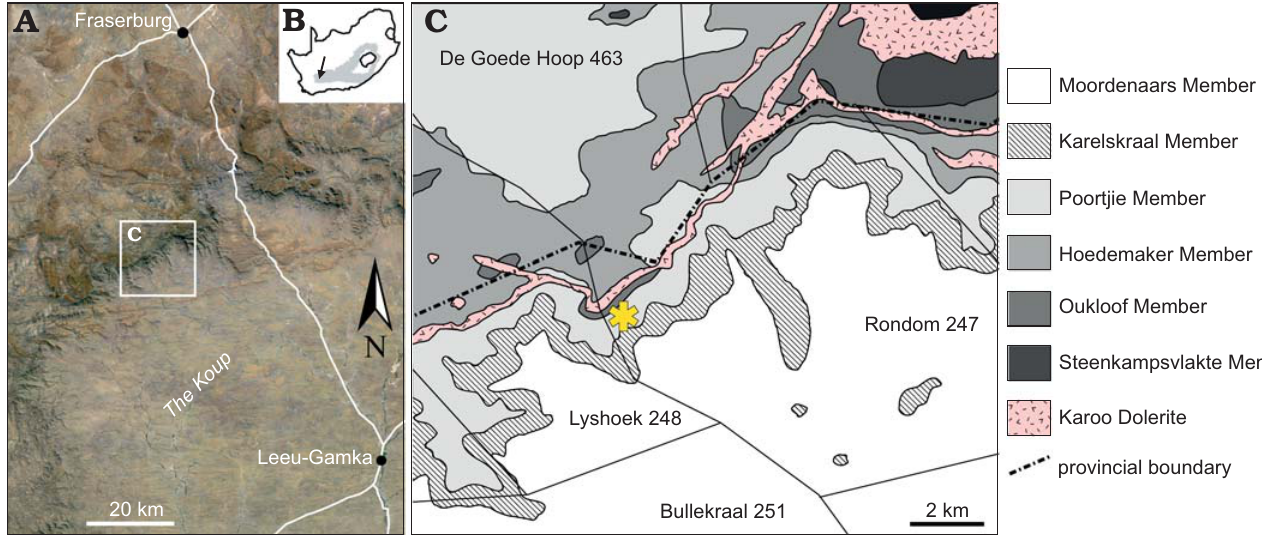
Fig. 1. A . Satellite map of the study area on the Nuweveld escarpment, Western Cape Province, South Africa. B . Map of South Africa; arrow indicates posi- tion of the locality within Main Karoo Basin (grey). C . Geological map and stratigraphy of Springfontein locality; asterisk indicates position of BP/1/7098.